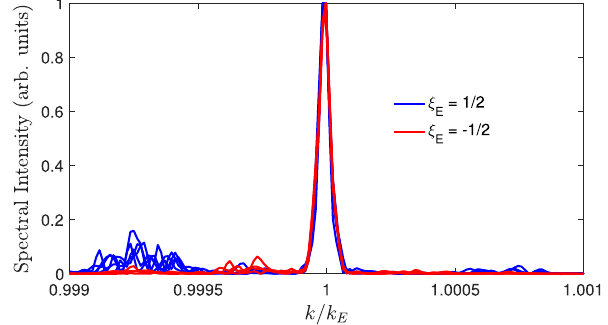
FIG. 10. FEL output spectrum for EEHG with ξ E < 0 (red) shows reduced spectral pedestal than ξ E > 0 (blue) on beam ffiffiffi p ¼ 3 broadband MBI noise. A 1 ; 2 ¼ 3 , a E ¼ 75 , with σ p 0 ρ ¼ 1 . 58 × 10 − 3 , σ =E ¼ 10 − 4 E